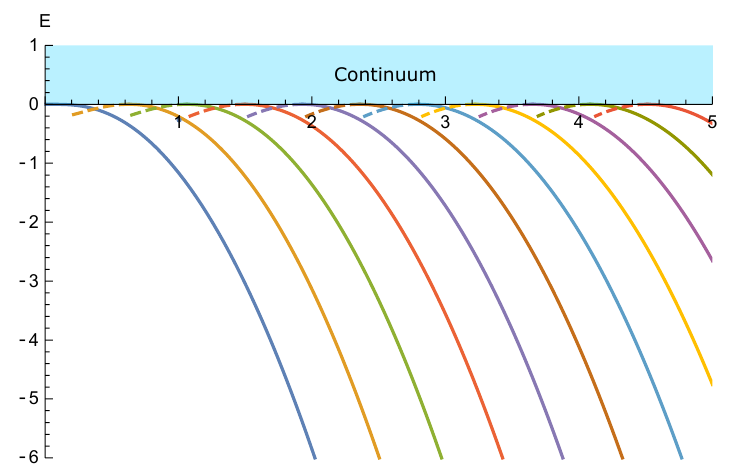
Figure 5 . Spectrum of the Schr(cid:127)odinger problem at (cid:30) = 1 : 5 for a range of values of the coupling. Solid lines show numerical data for the (cid:12)rst few bound states. For small ^ g there is only one bound state in the spectrum, but their number grows linearly with the coupling. Dashed lines show analytic continuation of the levels in the coupling ^ g beyond the point where they disappear from the bound state spectrum and become resonances (to be discussed in detail in section